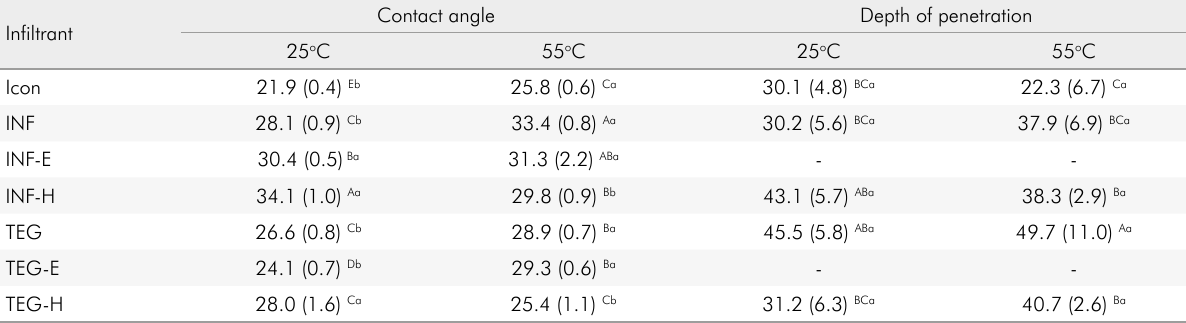
Table 4. Mean values of contact angle (o) and penetration depth (µm) of infiltrants, according to temperature. Infiltrant